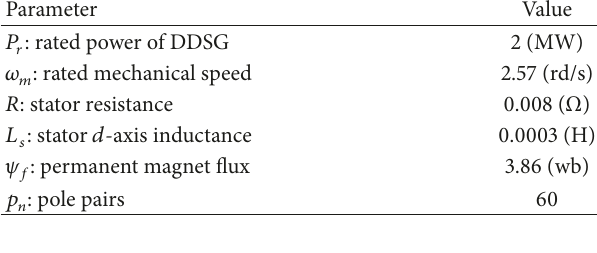
Table 2: Parameters of the turbine.